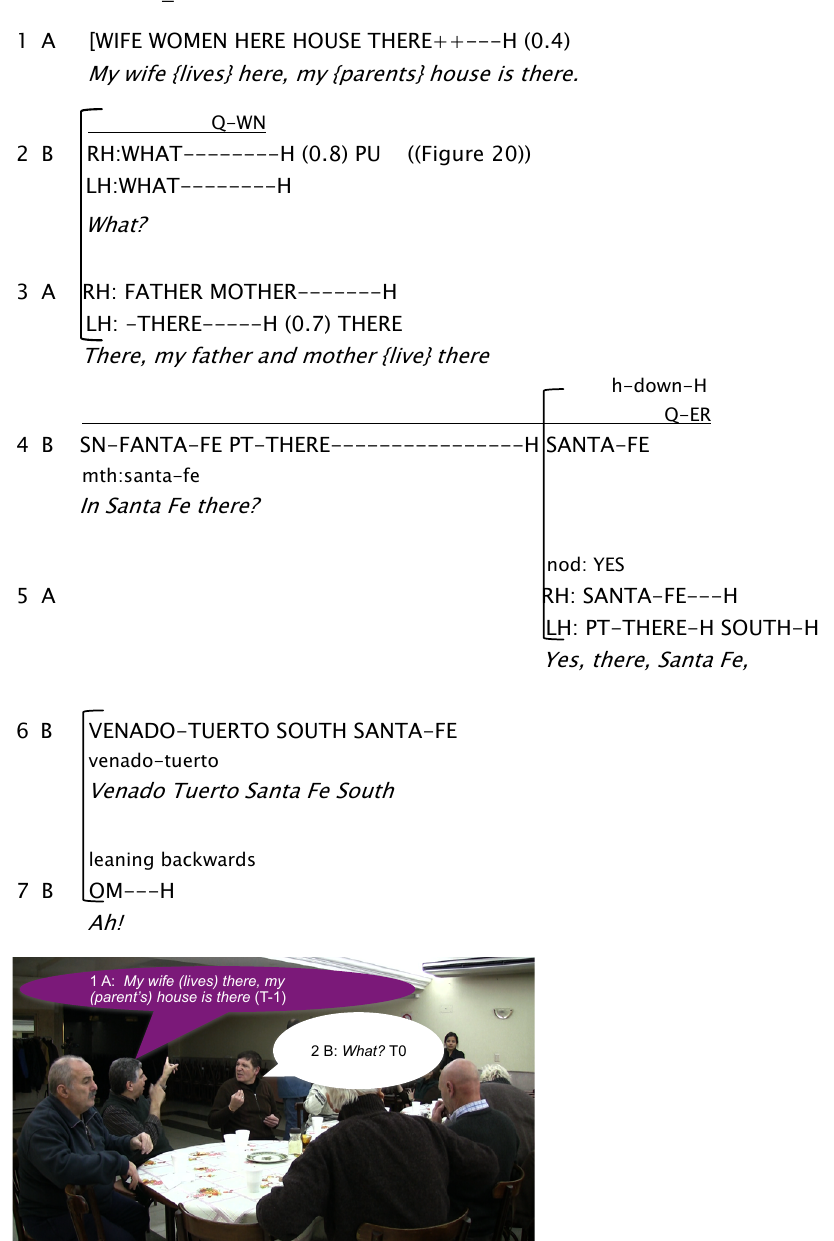
Figure 20. ‘What?’ , Person B (right) initiates repair by wrinkling his nose and bringing his eyebrows together in combination with a general question sign produced in parallel with both hands instead of the standard format with only one hand. In both examples, Person A fixes the problem by near-repeating the question. The solution turns are not verbatim repeats of the trouble source. In Extract 11 Person A specifies the reference of the trouble source ‘Your son, the oldest’ (line 5) that was omitted in the trouble source by only signing ‘… the oldest…?’, and then near-repeats the question ‘…{has he} left?’ . Extract 12 is similar, where Person A specifies the person reference in the solution turn, ‘my father and mother….’. This example is upgraded to a restricted type of initiation after Person A provides the solution to the open repair